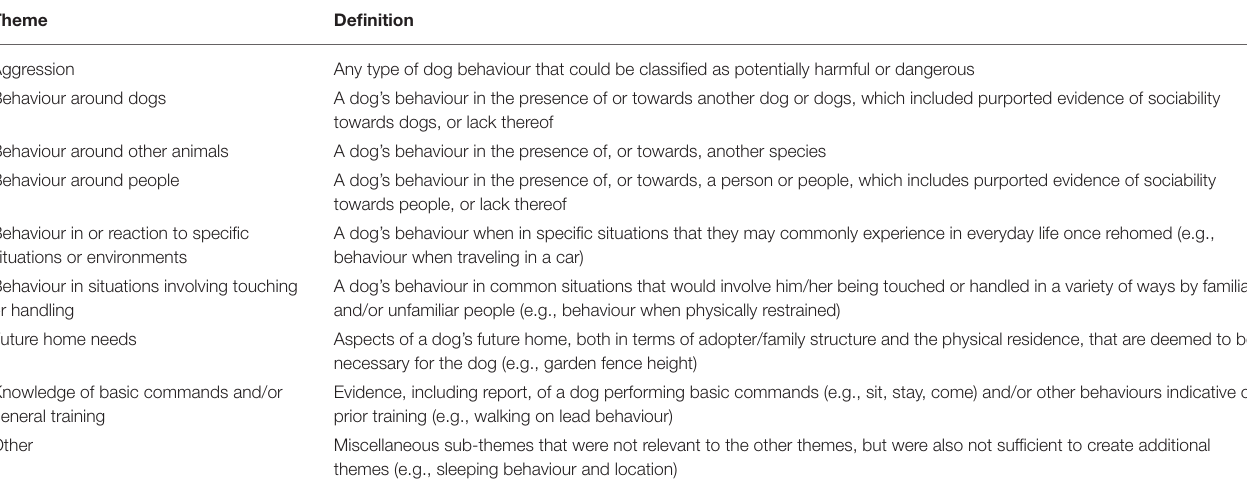
TABLE 1 | Themes present in pre-adoption dog behaviour